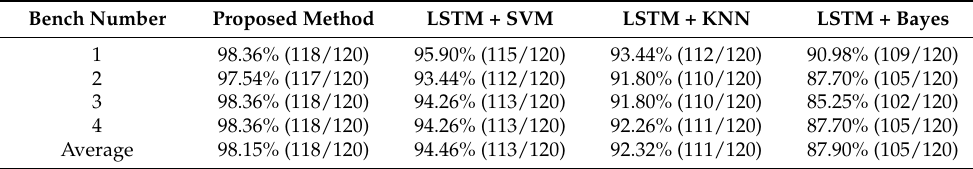
Table 8. Accuracies of different classifiers without LSTM interval Table 7. Accuracies of different classifiers under LSTM interval recognition.